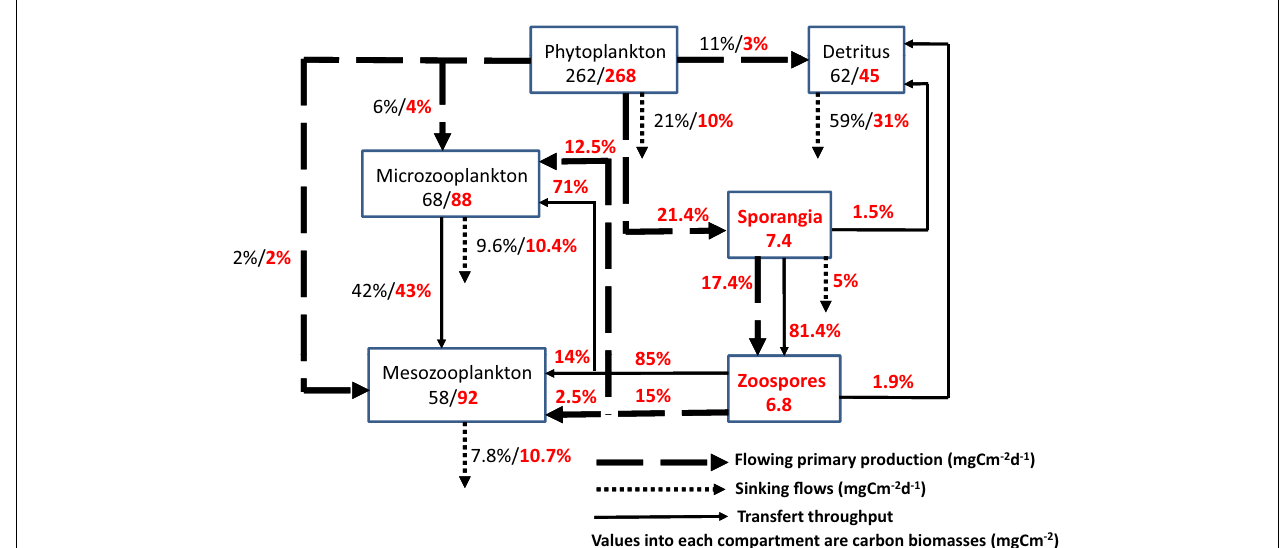
(zoospores) are highlighted in red color.The diagram corresponds to steady state models of the euphotic zone of the lake generated from a linear inverse modeling analysis. For more details, see the main text. Modified from Grami et al.